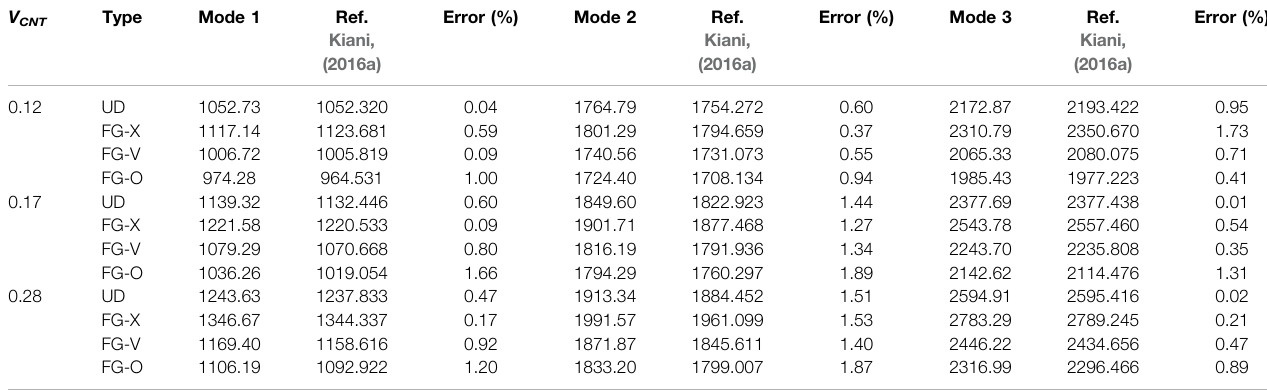
TABLE 3 | Effects of CNT volume fraction and distribution type on the fi rst three frequencies (CCCC).